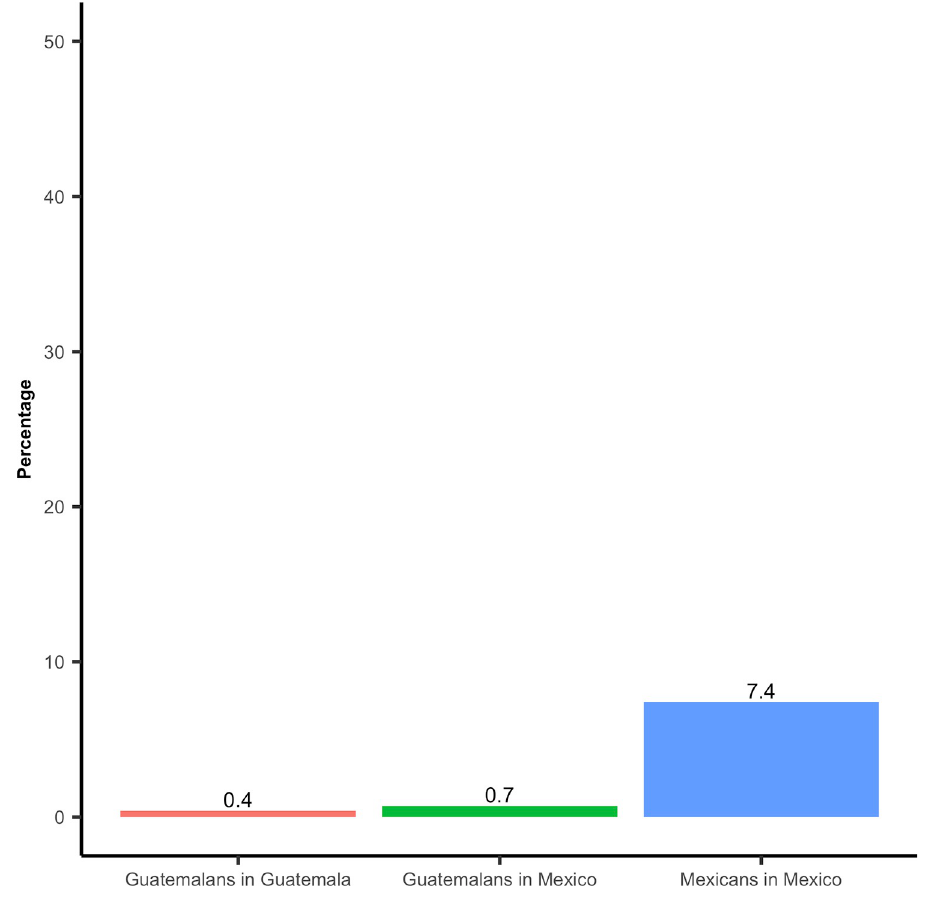
Fig 4. The reason for the last cross to a country where they were not living in was health-related, by mobility